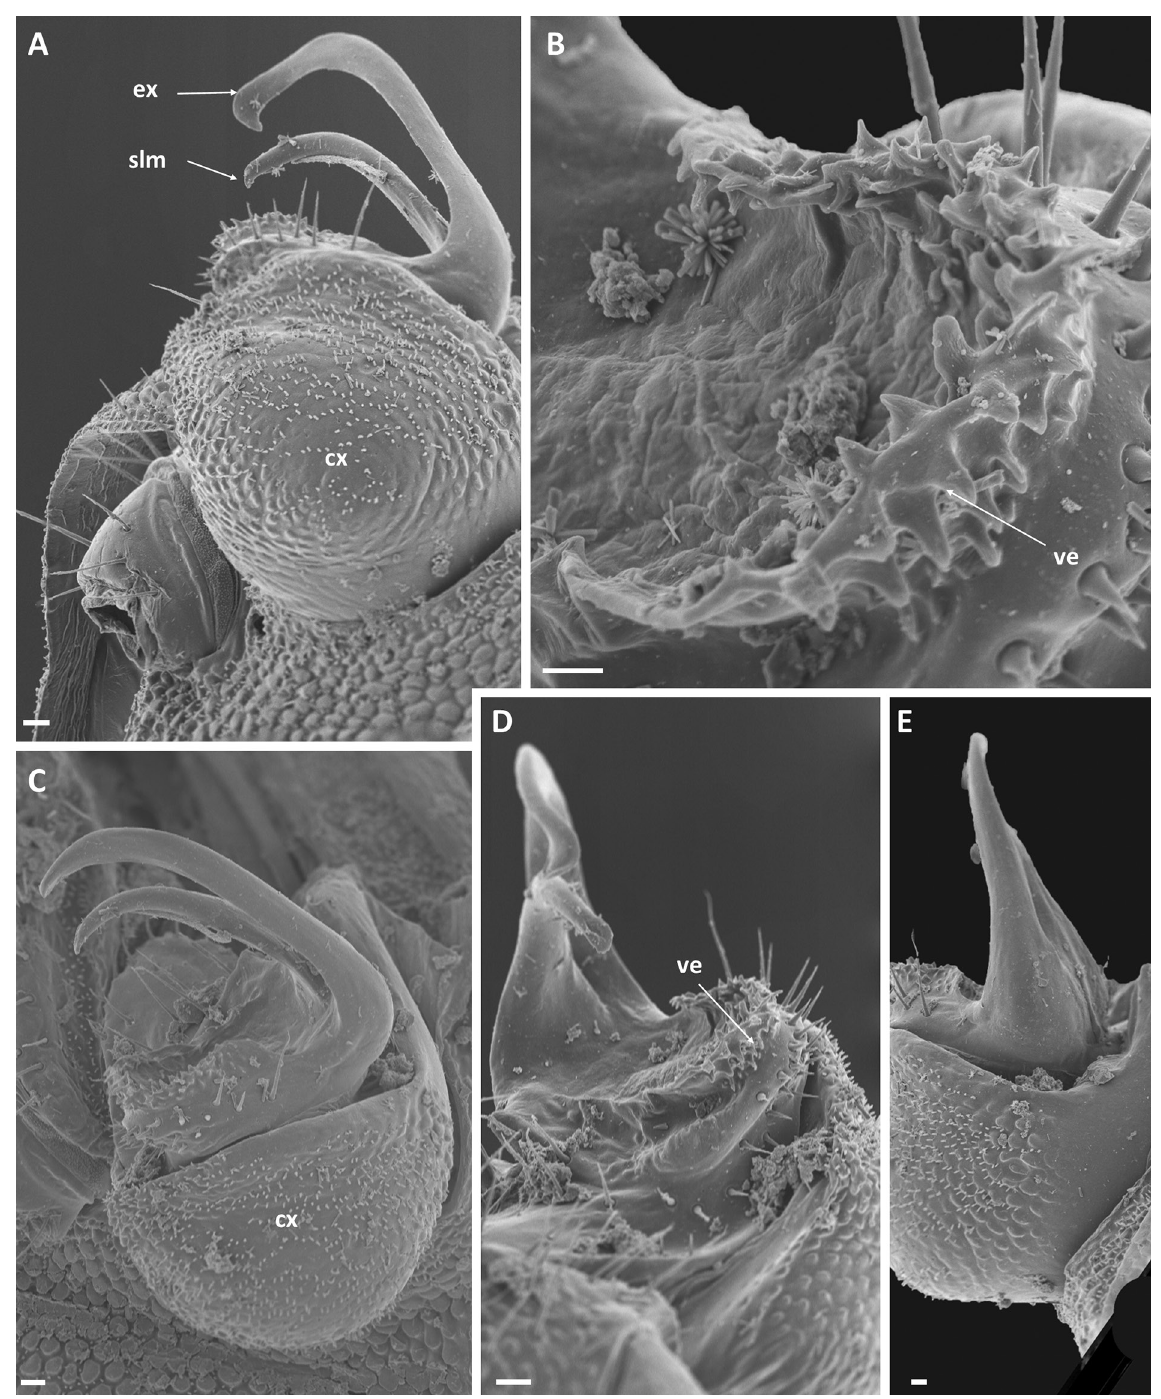
Fig. 9. Cryptocorypha cactifer sp. nov., paratype (NHMD 621836), ♂, from Mito Mitatu, left gonopod. A . Lateral view. B . Basal part of telopodite, showing jagged ?velum. C . (Sub)ventral view. D . Posterior view. E . Anterior view. Abbreviations: cx = coxa; ex = exomere; slm = solenomere; ve = velum? Scale bars: A, C–E = 0.01 mm; B = 0.005